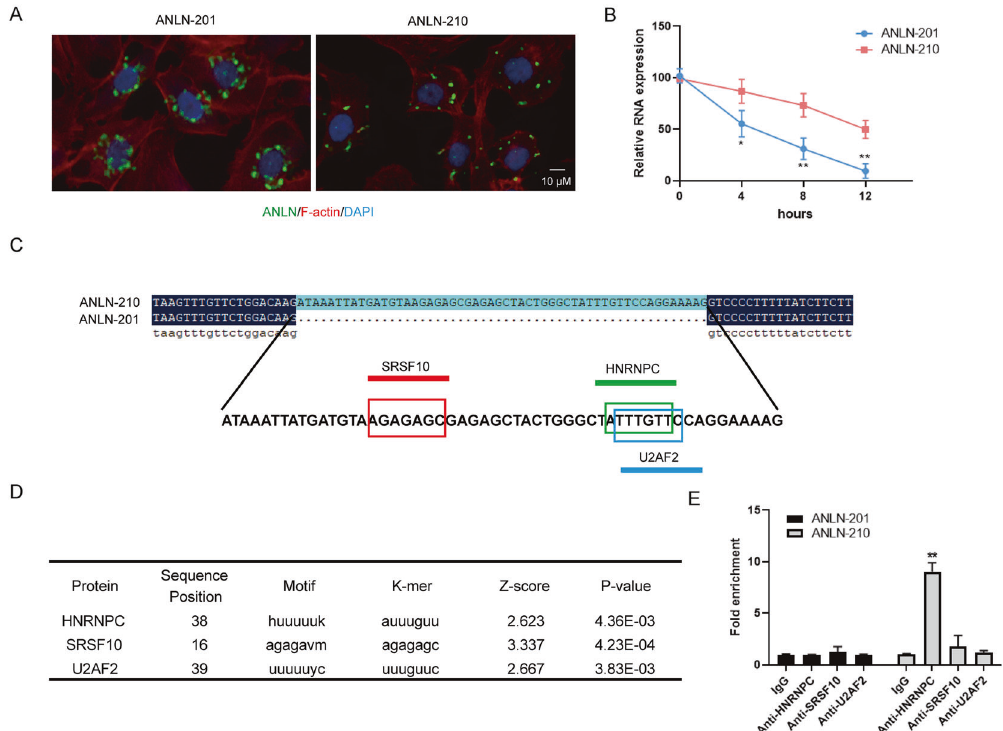
Fig. 4 The subcellular distribution of the two splice isoforms of ANLN. A Immuno fl uorescence staining for ANLN-201 and ANLN-210 in SCC- 9 cells. B The mRNA levels of ANLN-201 and ANLN-210 were examined in SCC-9 cells treated with 10 nM actinomycin D for 4, 8, and 12 h. ** P < 0.05, * P < 0.01. C Sequence alignment of nucleotides between ANLN-210 and ANLN-201. D The predicted RNA-binding protein with ANLN-210 was listed in the table. E RNA co-immunoprecipitation was performed between ANLN-201/ANLN-210 and HNRNPC/SRSF10/U2AF2. * P < 0.05, ** P < the results reveal that the two splicing isoforms of ANLN synergistically promote tumor progression in vivo in different ways.